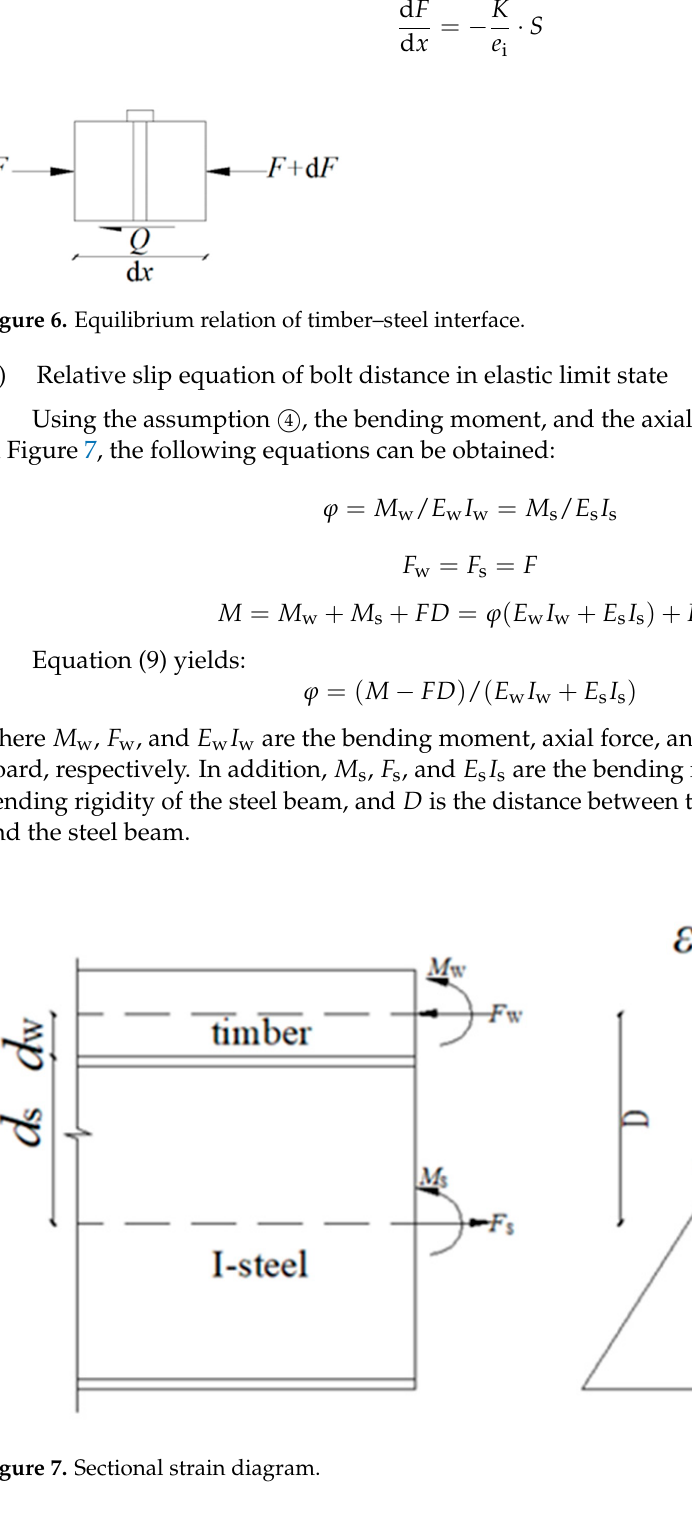
Figure 7. Sectional strain diagram.